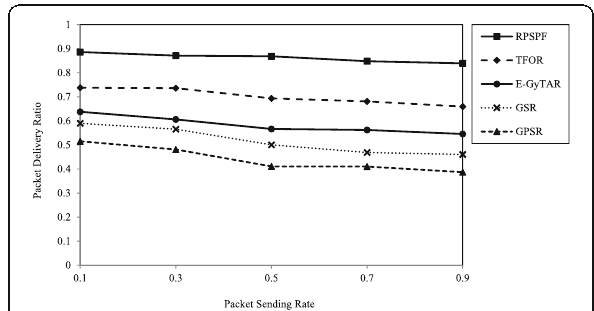
Fig. 6 Packet delivery ratio as a function of the packet sending rate (400 nodes). RPSPF represents Reliable Path Selection and Packet Forwarding Routing Protocol which is proposed approach and is represented by a solid line with a square. TFOR is traffic flow- oriented routing protocol and is represented by a dashed line having rhombus. E-GyTAR is Enhanced Greedy Traffic Aware Routing protocol and is represented by a solid line with circle. GSR is geographic source routing protocol and is presented by a dotted line having a cross. GPSR is Greedy Perimeter Stateless Routing Protocol and is presented by a dashed line having a